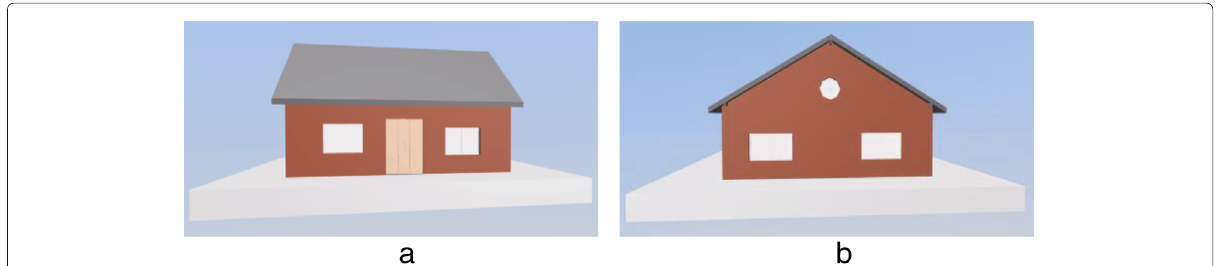
Fig. 4 Results after extracting the external components on different faces. All external building components including bases, roofs, walls, and windows are extracted accurately. a Front b